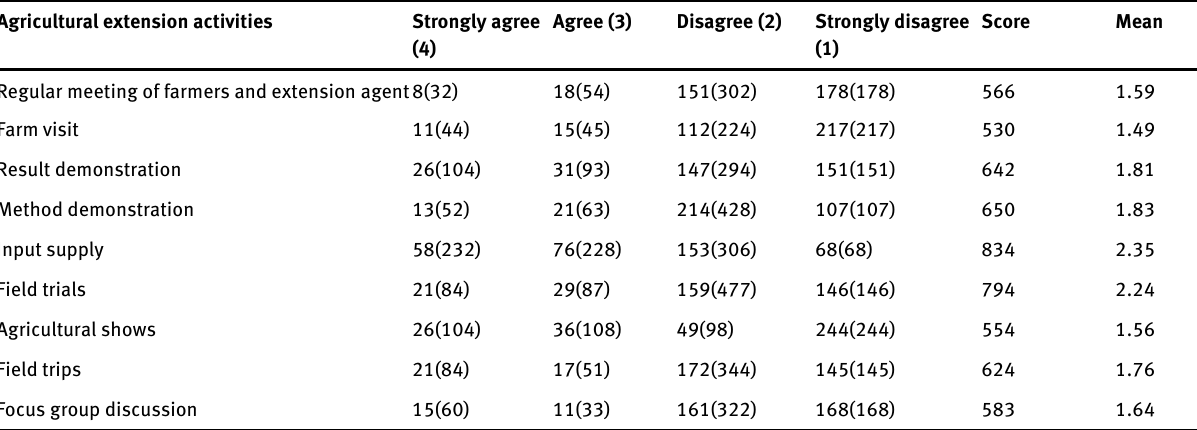
Cut-off score = 2.50 (≥ 2.50 = inclusion; < 2.50 = poor inclusion)